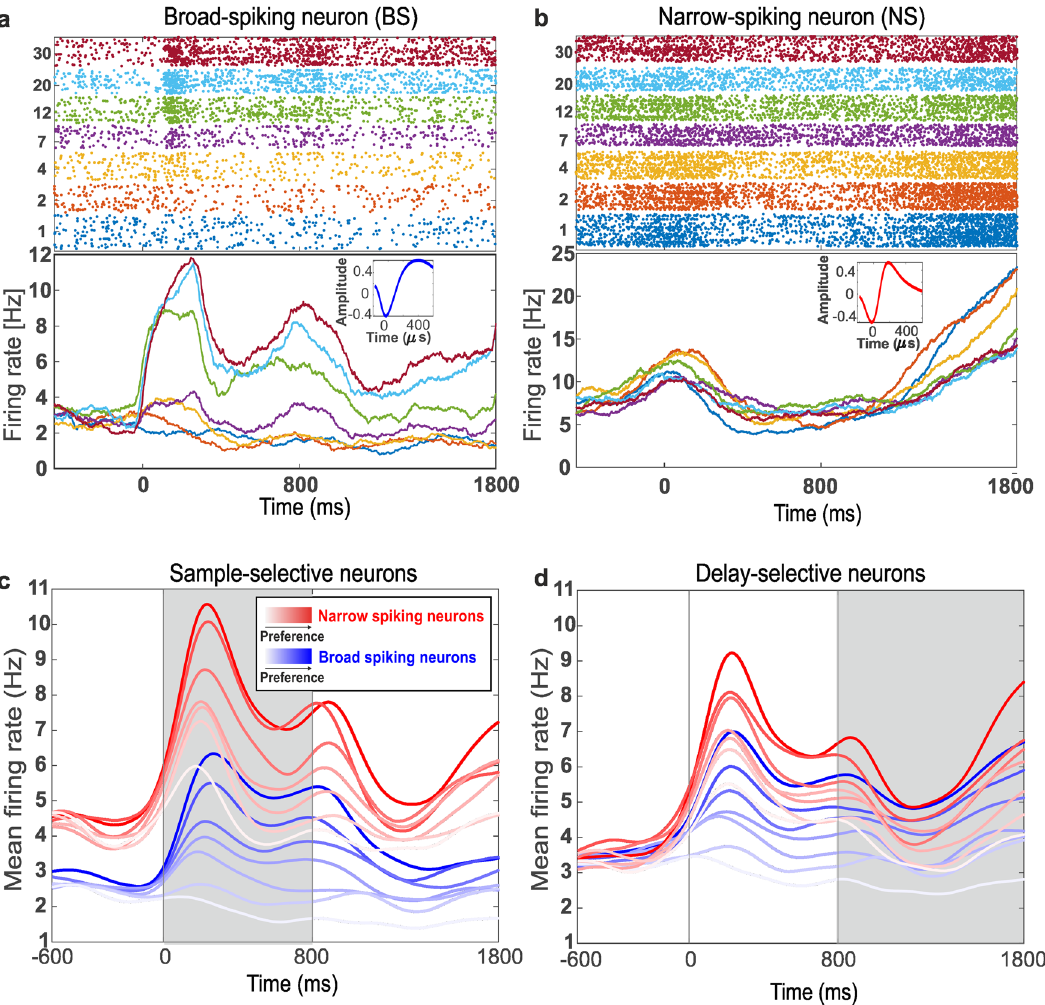
Fig. 4 Firing-rate modulation of BS and NS numerosity-selective neurons. a Responses of an example BS neurons selective to numerosity 30 during the sample and delay periods. Top panel : dot-raster histograms with each dot representing one action potential. Bottom panel : averaged spike density function (activity averaged and smoothed by a 150-ms Gauss kernel). Colors in the dot-raster and spike density functions correspond the shown numerosity during the sample period. Inset: Average action potential waveform of this neuron. b Example NS neurons selective to numerosity 2. Same layout as in a . ( c,d ) Average spike-density histograms of BS and NS neurons that were selective for numerosities 1 – 30 during the sample ( c ) and delay ( d ) periods. Responses to more preferred (dark colors) and less preferred (light colors) numerosities are depicted. Table 2 Frequency of broad- and narrow-spiking neurons and numerosity selectivity in different cell classes.